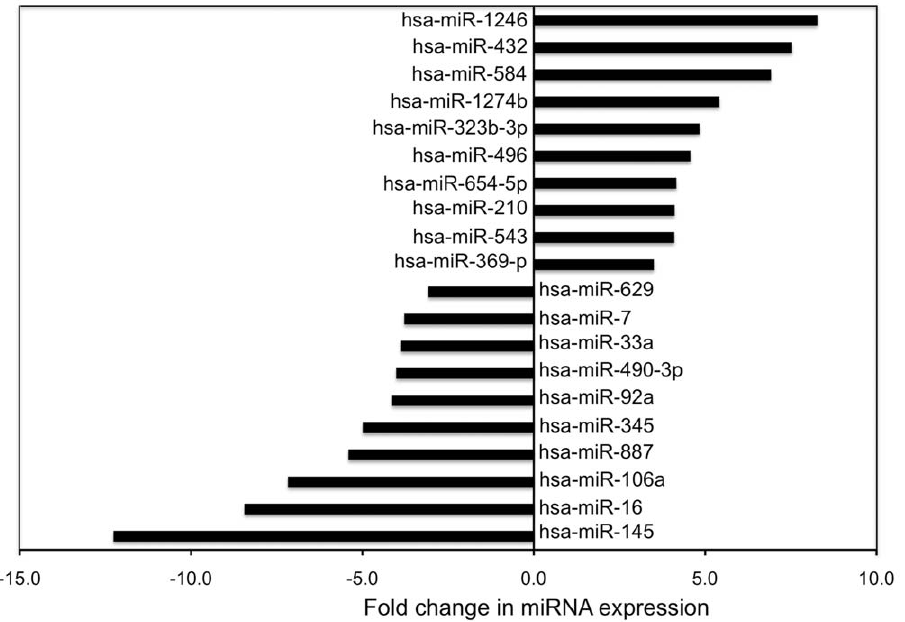
Figure 3. miRNAs differentially regulated in IMR90 senescence. MiRNAs are labeled with miRBase terminology. The x-axis denotes the fold change in sequence reads between young and senescent IMR90 cells: miRNAs overexpressed during senescence have positive values and miRNAs underexpressed during senescence have negative values. These miRNAs were selected for display because they have high expression level (sequence read counts) in at least one of the states (young or senescent) and show a high fold change. For a complete list of differentially expressed miRNAs, see Table S2.